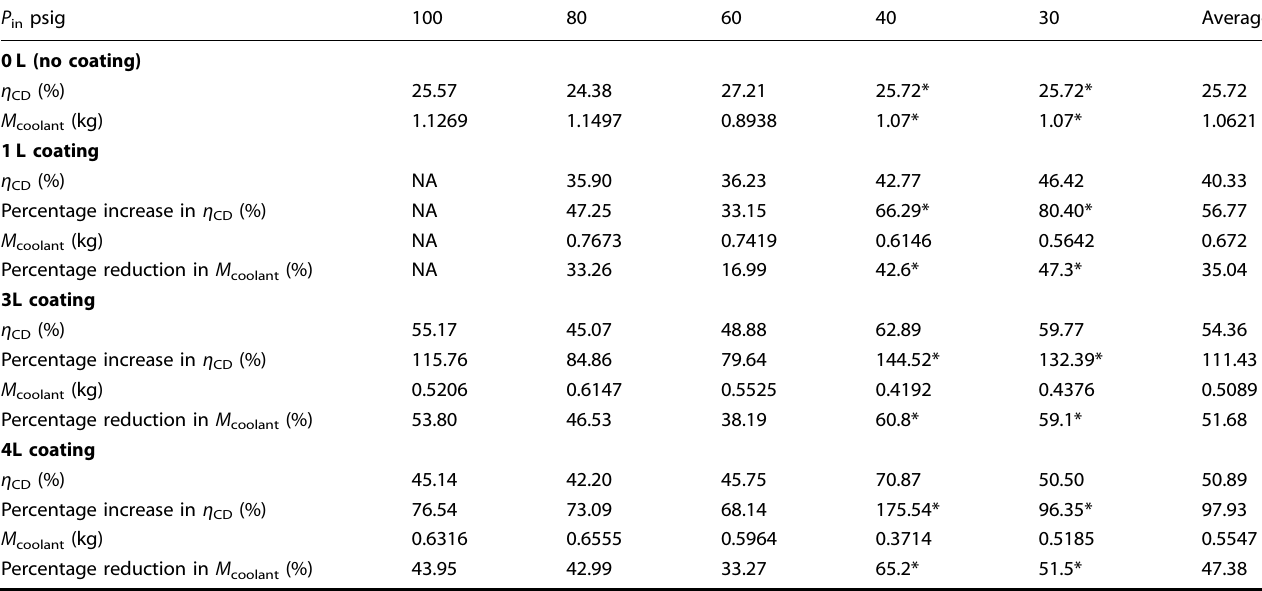
Table 1. The chilldown ef fi ciencies, η CD ; the percentage increase in η CD over the base case, 0L; total LN 2 consumed for chilldown process, M coolant ; and percent reduction in LN 2 consumption over the base case, 0L, for different coating layers and source